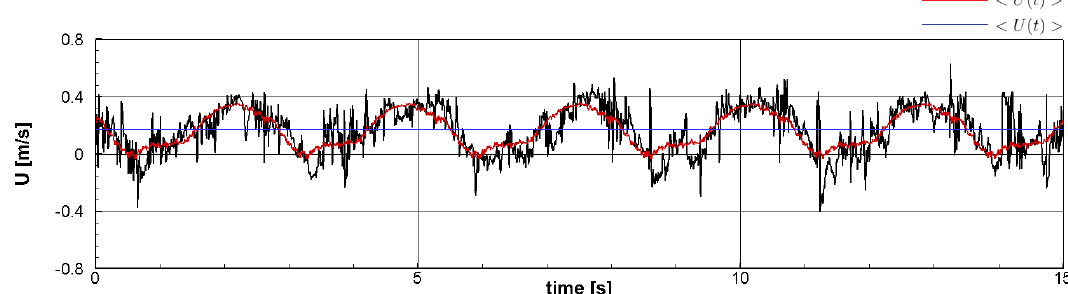
Figure 11. An example of the triple decomposition: the streamwise velocity signal (black), phase-averaged velocity (red), and time-averaged velocity